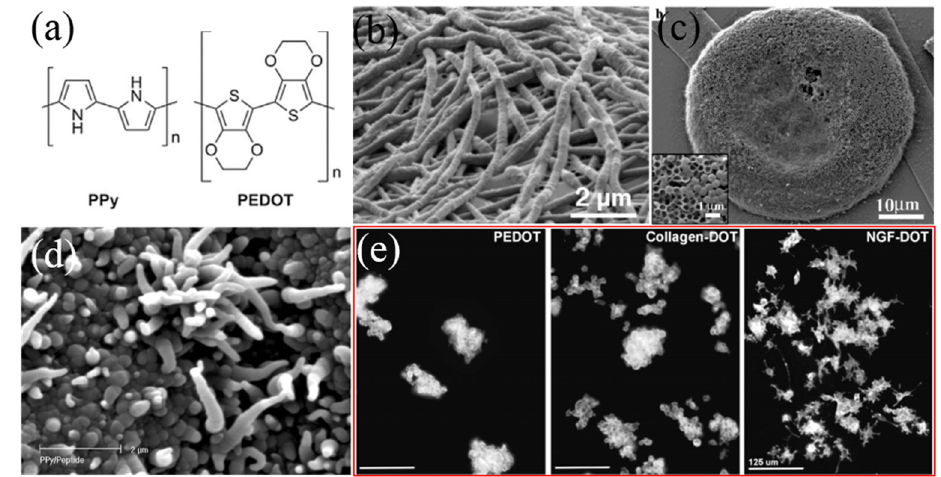
Figure 10. ( a ) Chemical structures of PPy and PEDOT [108] ; ( b ) SEM image of PEDOT coating [109] ; ( c ) SEM image of PEDOT obtained using polystyrene as template [105] ; ( d ) SEM image of PEDOT/DCDPGYIGSR composite coating [106] ; ( e ) Neurotrophic factor combined with PEDOT promoted the growth of neural cells [107] . Reproduced from the mentioned references with permission from the related journals.